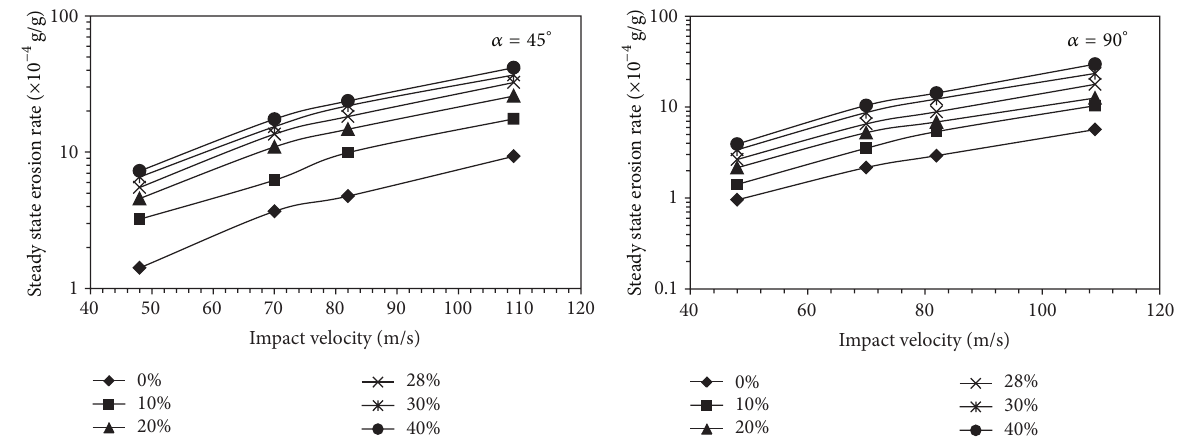
Figure 5: Variation of steady-state erosion rate of PVA/DPL composite as a function of impact velocity (45–109m/s).